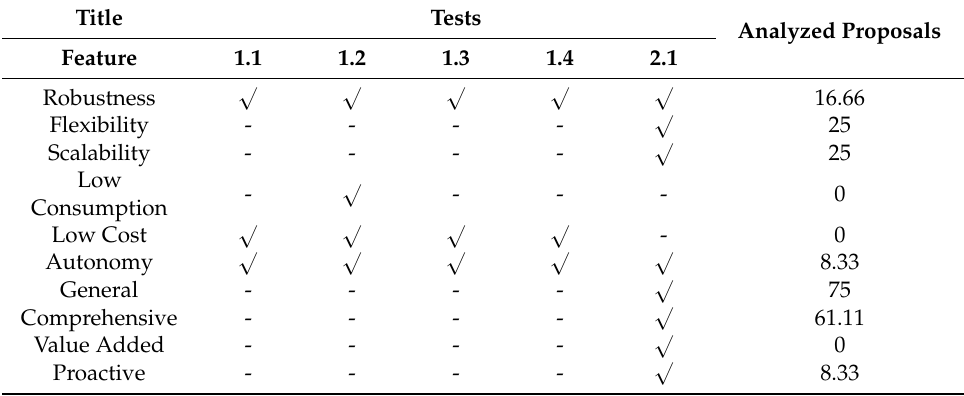
Table 4. Formulated objectives